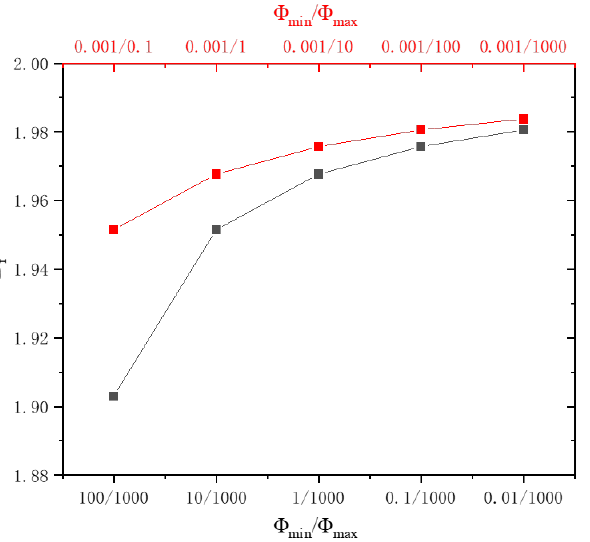
Figure 10. The influence of the pore diameter distribution on the area fractal